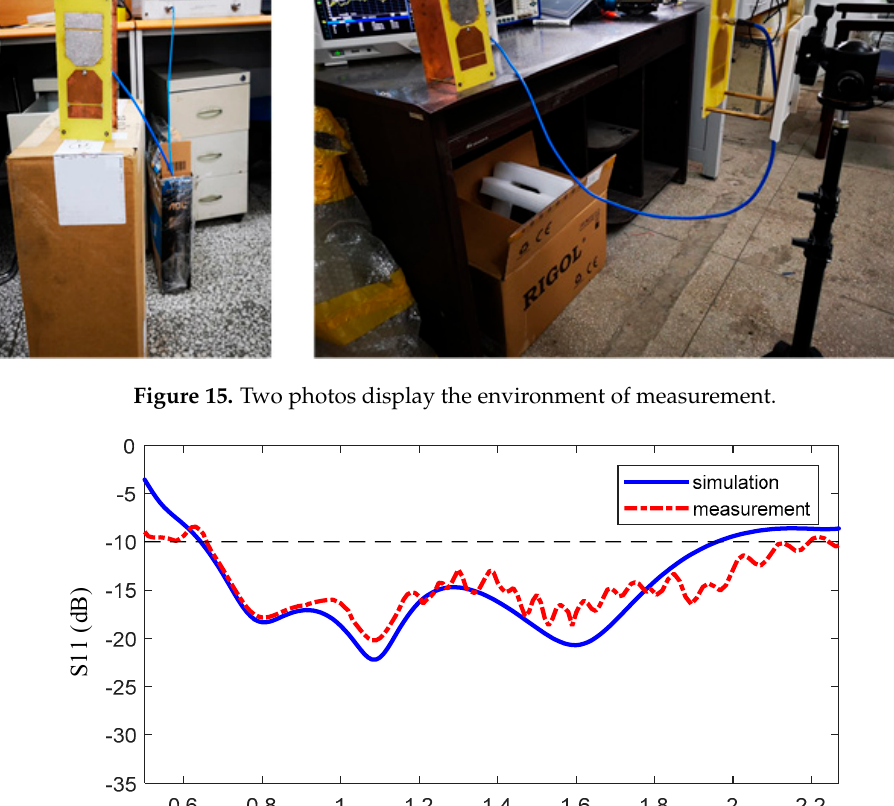
Figure 15. Two photos display the environment of measurement.